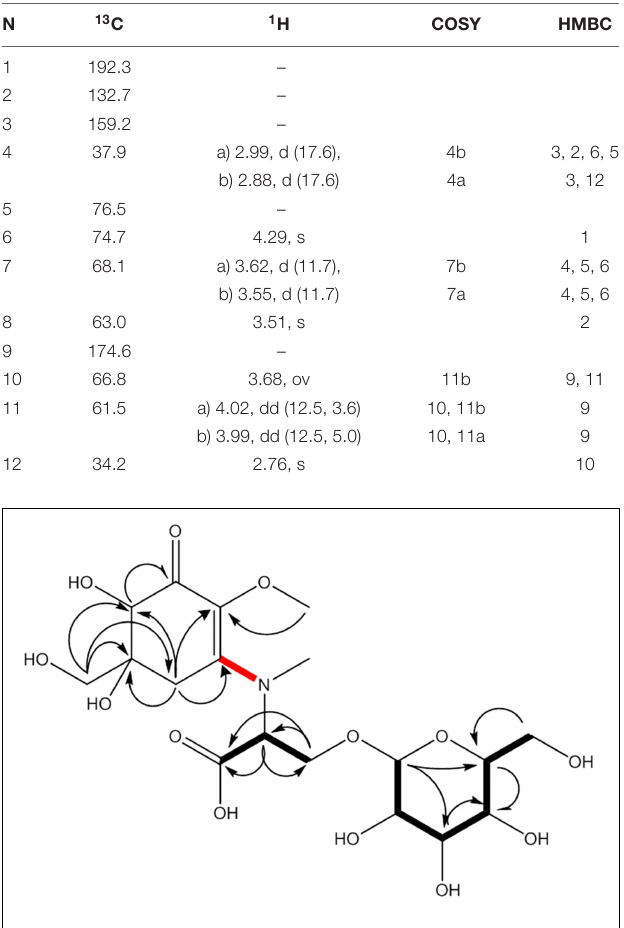
FIGURE 2 | MAA compound 1 (klebsormidin A) isolated from extracts of Klebsormidium crenulatum was assigned to the molecular formula C 18 H 29 NO 13 , as established by a positive [M + H] + ion at 468.1699. Uncertain position of the side chain due to missing long range correlation is marked in